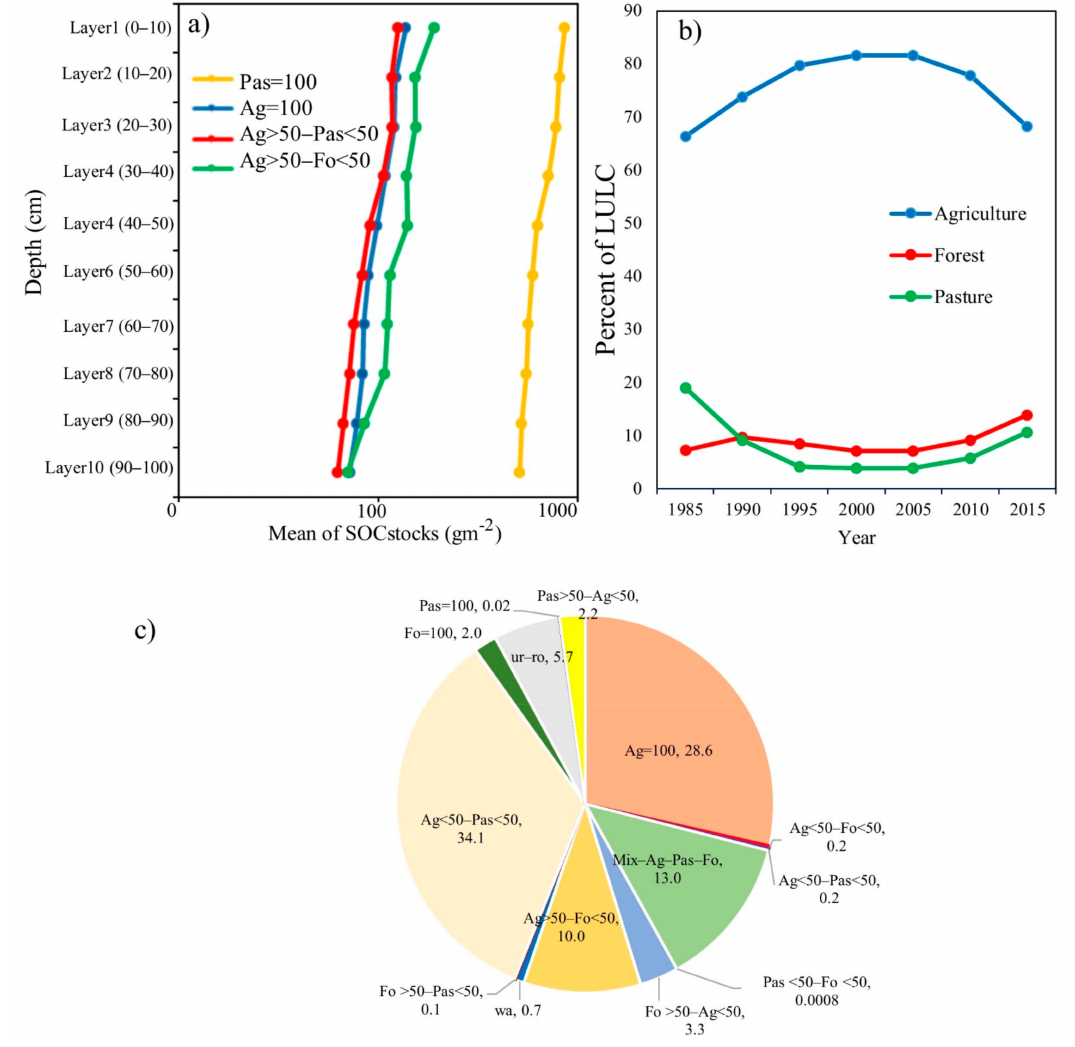
Figure 4. Mean values of SOC stocks (gm − 2 ) at 0–100 cm soil depth over different LULC history classes from the study ( a ); rel- ative frequency of LULC (in percent) during 1985–2015 ( b ); pie chart of the percent of area for each LULC history classes ( c